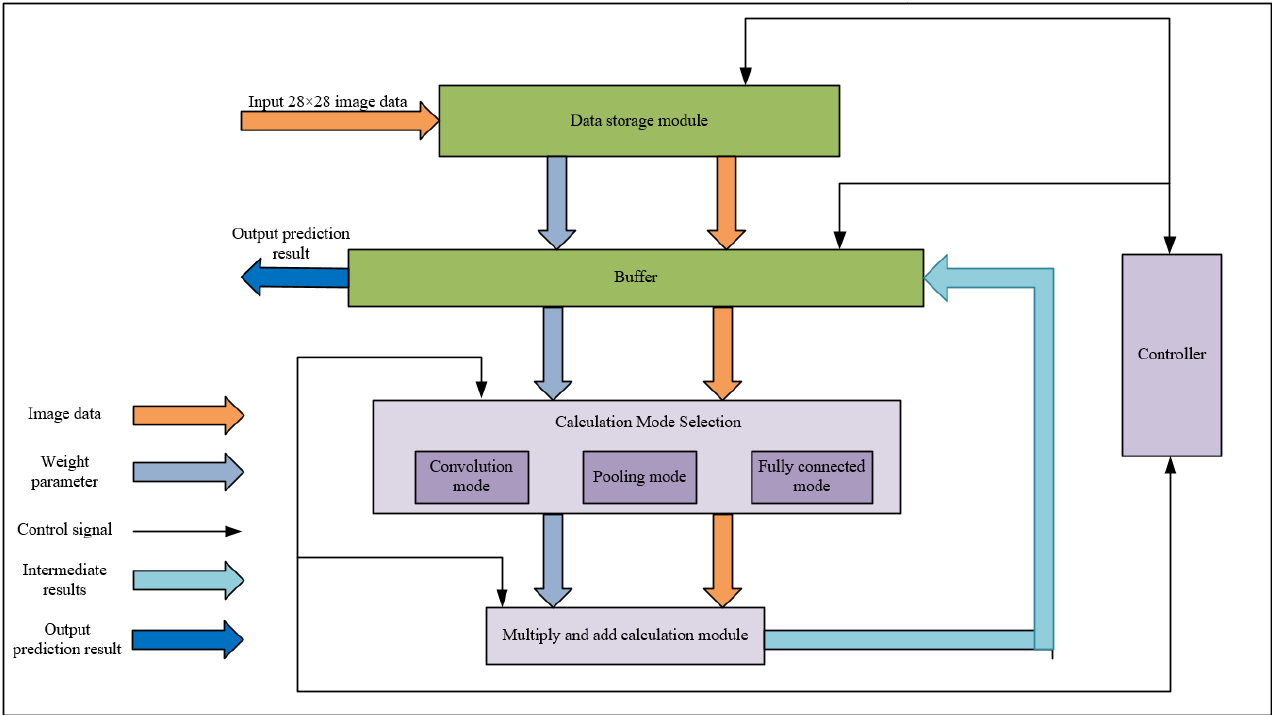
Figure 7. The overall hardware design structure of